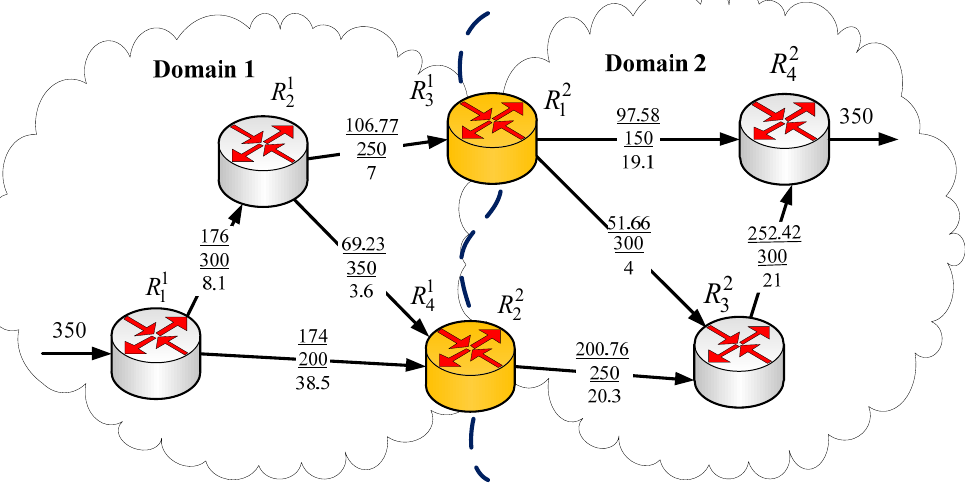
Figure 6. Solution to the inter-domain QoS routing problem after the first iteration of the coordination procedure following the normalized requirements (23).